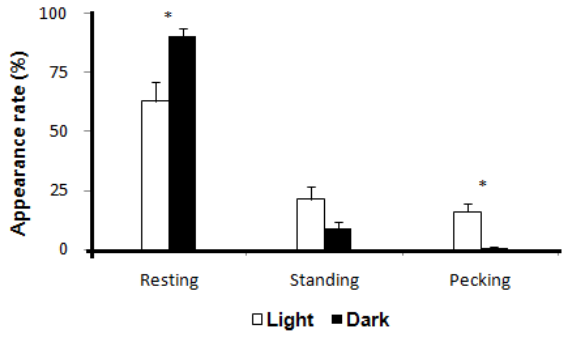
Figure 2. Behaviors of broiler chickens during 2 h exposure to light and dark. Asterisks indicate the statistically significant difference